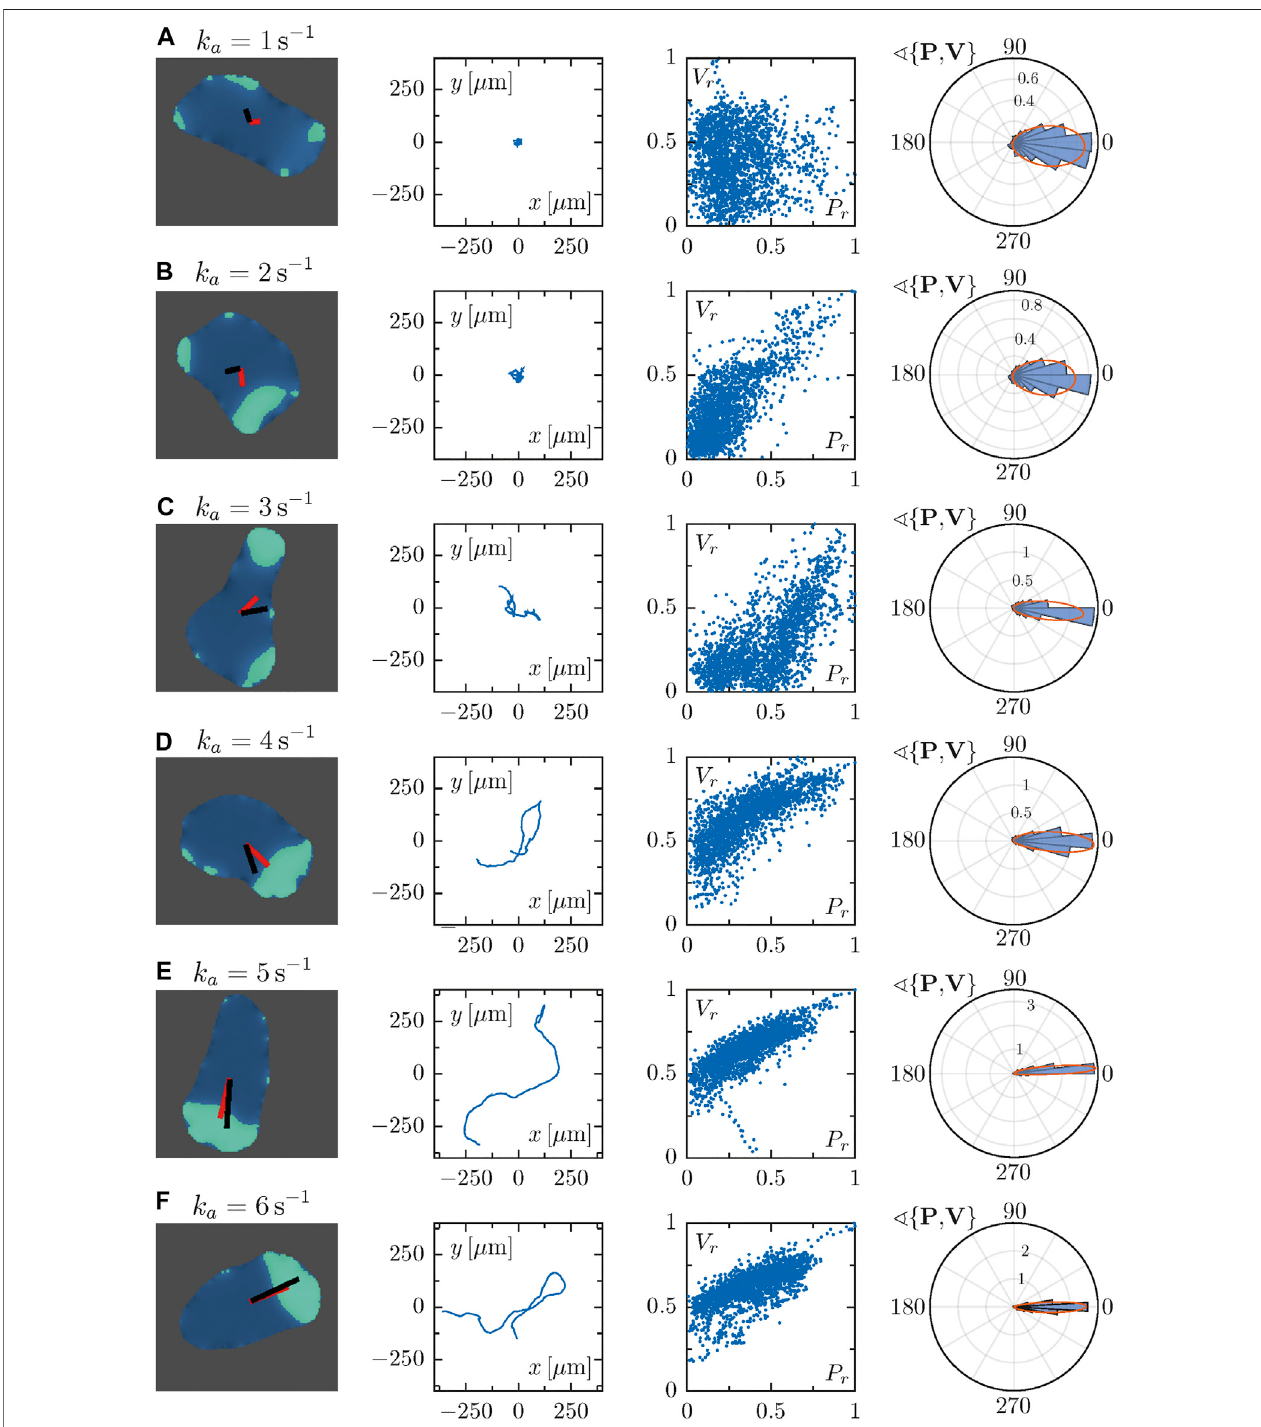
FIGURE 3 | Each row corresponds to a particular single cell phenotype for increasing values of the parameter k a . In the fi rst column, snapshots along with the polarizationandvelocity vectors P and V aredepictedinblackandred,respectively. Thecorrespondingtrajectoryisshowninthesecondpanels.Thirdpanelsrepresent the correlation of the magnitudes of vectors P and V , which were normalized with respect to the maximal value observed during a simulation. The fourth column panels representcircularhistogramsfortheanglebetweenthevectors P and V .Parameter values: (A) k a =1s − 1 , (B) k a =2s − 1 , (C) k a =3s − 1 , (D) k a =4s − 1 , (E) k a =5s − 1 , (F) k a = 6 s − 1